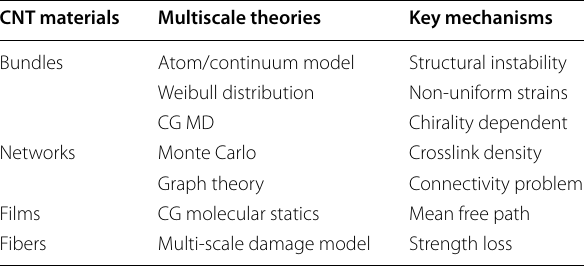
Table 1 Multiscale theories and key mechanisms of CNT